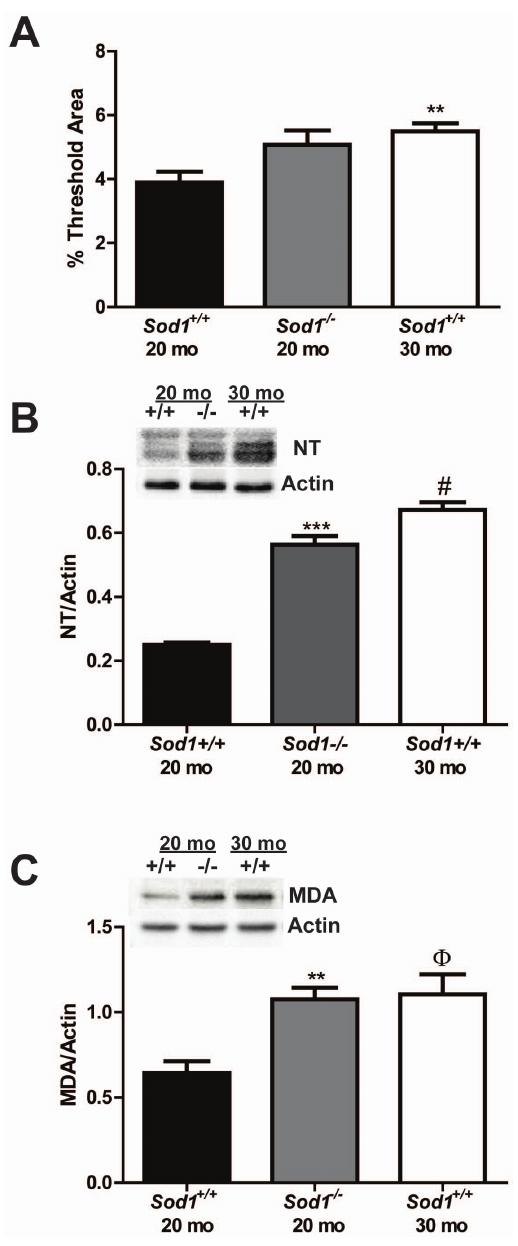
Figure 1. Assessment of oxidative damage in the cell body of sensory neurons. Oxidative damage was assessed in DRG neurons of Sod1 mice by A) quantitatively assessing the autofluorescence of lipofuscin, and by western immunoblotting of B) nitrated protein (nitrotyrosine; NT) and C) oxidative lipid degradation (malondialdehyde; MDA). The Sod1 + / + mice at 20 mo, Sod1 2 / 2 mice at 20 mo, and Sod1 + / + mice at 30 mo are represented by white, black, and gray bars, respectively. **p , 0.01 and ***p , 0.0001 compared to age-matched Sod1 + / + mice; W p , 0.05 and # p , 0.0001 compared to Sod1 + / + mice at 20 mo; n $